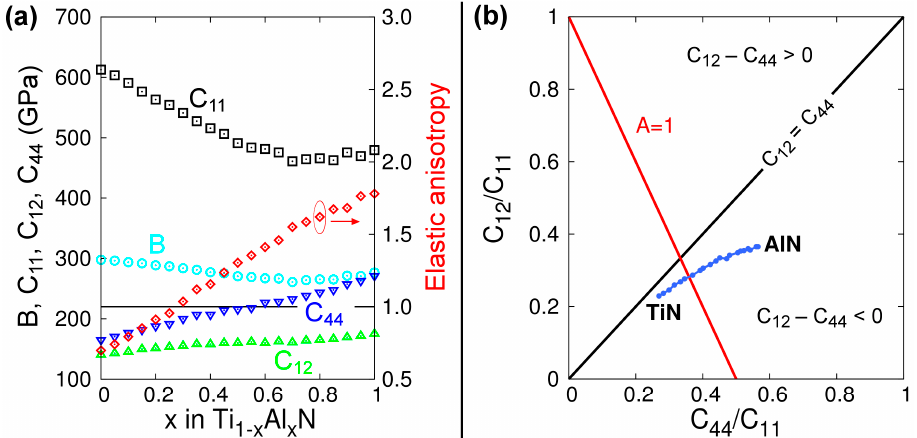
Figure 2. ( a ) Elastic constants B (cyan circles), C 11 (black squares), C 12 (green triangles), and C 44 (blue inversed triangles), as well as Zener’s elastic anisotropy A = 2· C 44 /( C 11 – C 12 ) (red diamonds), as a function of x within the Ti 1 − x Al x N system. The red circle and arrow are used to indicate that the elastic anisotropy data point refers to the right-axis scale. ( b ) Blackman’s diagram constructed using data from (a). The 45° solid black line represents the zero Cauchy pressure, C 12 = C 44 . The red solid line represents the conditions for elastic isotropy A = 1.